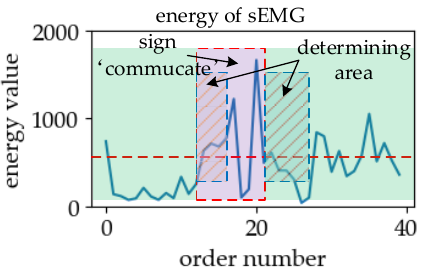
Figure 24. Segmentation in the segmentation – recognition mechanism. The purple part in the red box is the effective region of sign language “ communication ” . The green shadows are the blank region. The shaded part with oblique lines in the blue box is the determining area for the beginning and ending positions of the effective region. The red line is the contour of the energy threshold.